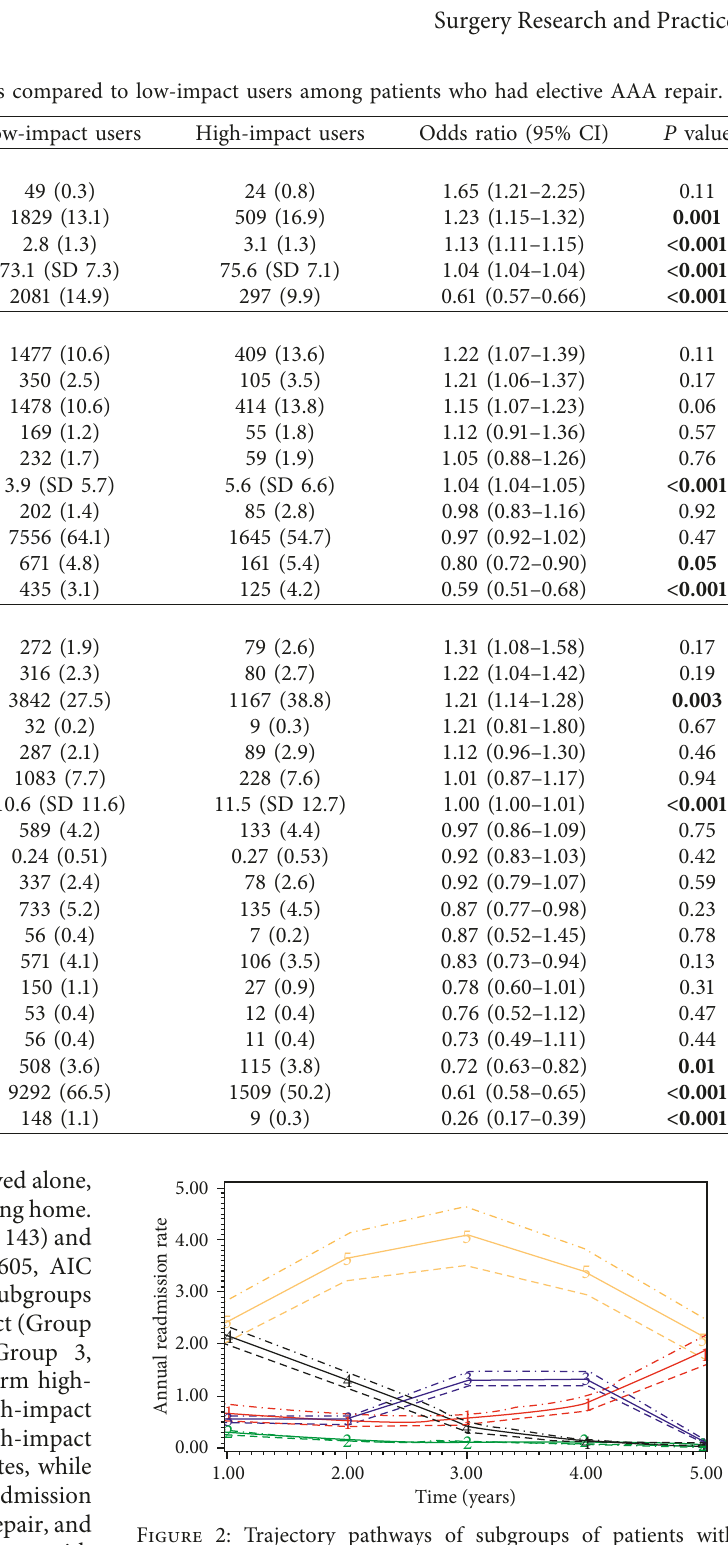
Figure 2: Trajectory pathways of subgroups of patients with elective EVAR repair (the horizontal axis starts with annual readmission rate after one year, and the dotted lines represent 95% confidence intervals for each